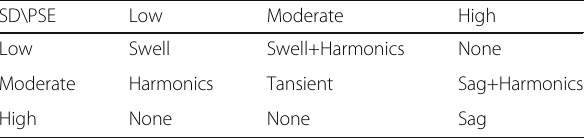
Table 1 Rule Editor for IT2FLS